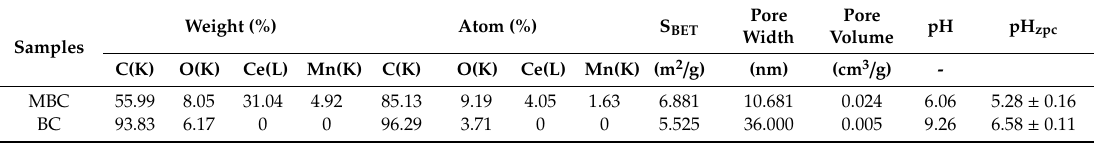
Table 1. Physiochemical properties of the pristine biochar and Ce-Mn modified biochar.